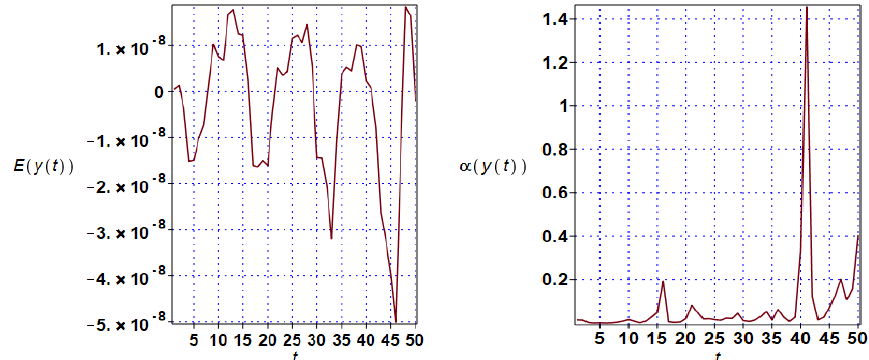
Figure 3. The expected values of the MEMS device vibration ( left ) and its coefficient of variation ( right ). tion ( right